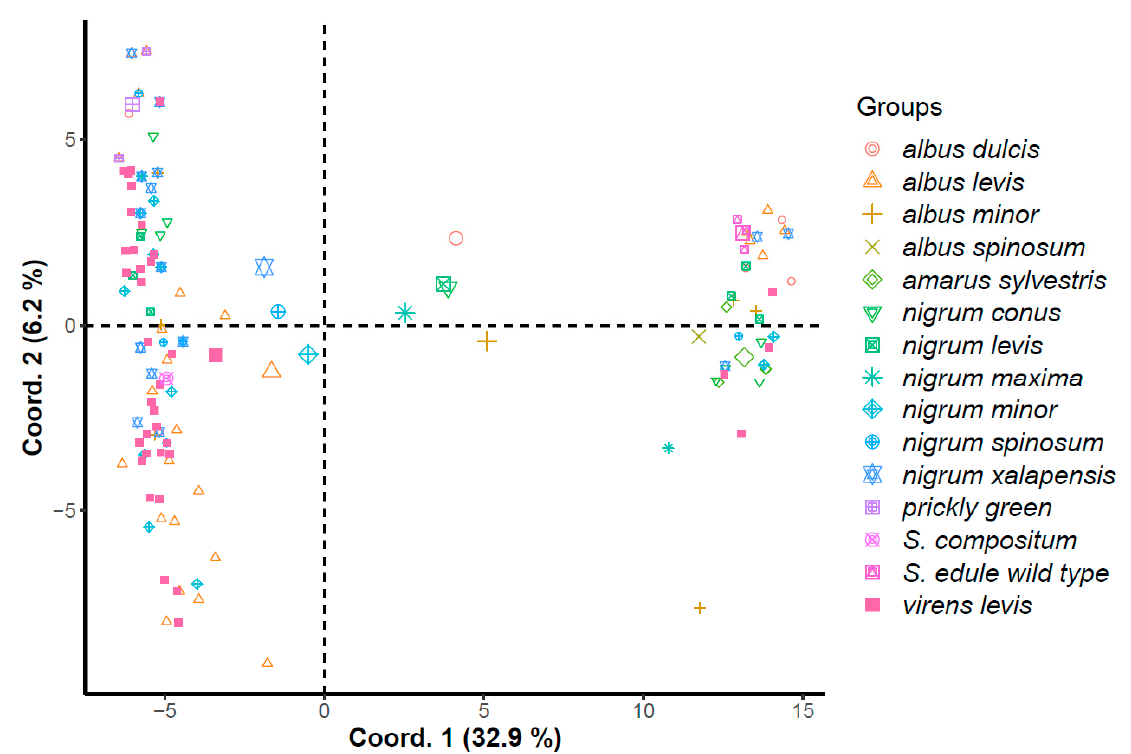
Figure 5. First two principal coordinates for accessions of varietal and wild complexes of S. edule using AFLP molecular markers.